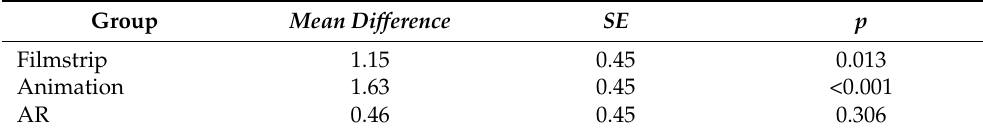
Table 3. Group comparison of mean scores for domain-specific knowledge in pre- and post-test. Group